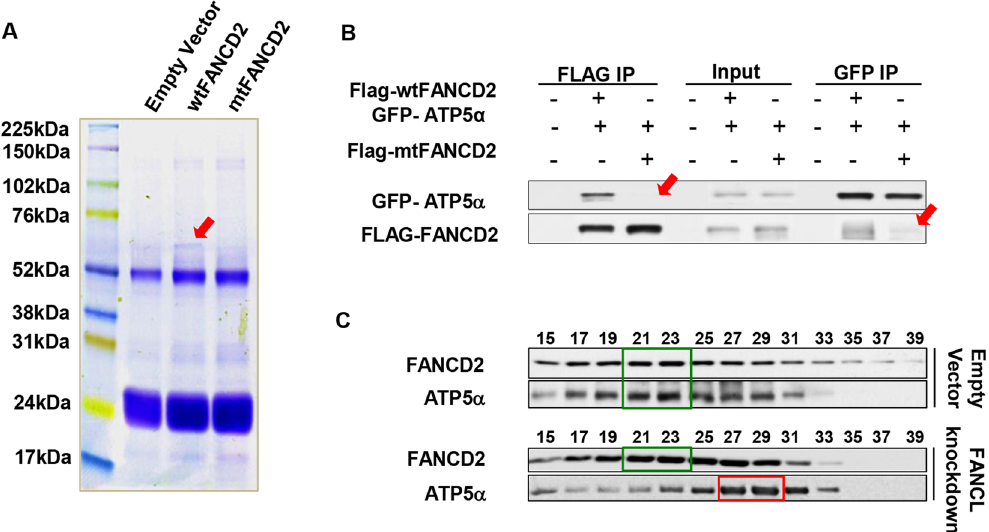
Figure 1. Interaction between FANCD2 and ATP5 α . ( A ) Simple blue-staining of an 8–16% gradient gel shows “an additional extra band” in the “wtFANCD2”-lane but not in the other lanes. Flag-IP elutes were resolved in an 8–16% gradient gel, which were prepared from Flag-vector, Flag-wtFANCD2 or mtFANCD2- containing plasmids transfected 293T cells. “The extra band” pointed by a red arrowhead was sliced for mass spectrometry. ( B ) Confirmation of the interaction between monoubiquitinated FANCD2 and ATP5 α . 293T cells were transiently co-transfected with GFP-fused ATP5 α and Flag-wtFANCD2 or Flag-mtFANCD2 K561R. Cell lysate was prepared 48 hr post-transfection. Both Flag and GFP antibodies were used to perform reverse immunoprecipitation (IP) and Western blotting (WB). As red arrowheads indicated, Flag-mtFANCD2, unlike Flag-wtFANCD2, is not clearly associated with GFP-ATP5 α (The equal transfection efficiency of 293T cells with GFP-fused ATP5 α and Flag-wt or mt FANCD2 is shown in Supplementary Fig. 1A and B). ( C ) wtFANCD2 and ATP5 α proteins peak at the same gel-filtration fractions prepared from control cells but not cells carrying silenced FANCL, which leads to a compromised FA-complex E3 and compromised monoubiquitination/ activation of FANCD2. The sepharose 6B chromatography (gel filtration) was performed using U2OS cells stably transfected with empty vector or Lentivirus-FANCL-shRNA (Supplementary Fig. 1C). The peak of endogenous FANCD2 overlapped with the one of endogenous ATP5 α protein in cells carrying a normal basal level of FANCD2 monoubiquitination, but not in the cells carrying a compromised basal level of FANCD2 monoubiquitination (resulting from silenced FANCL) (Fractions #15 and #39 correspond to the size markers of 2000 kDa and 669 kDa